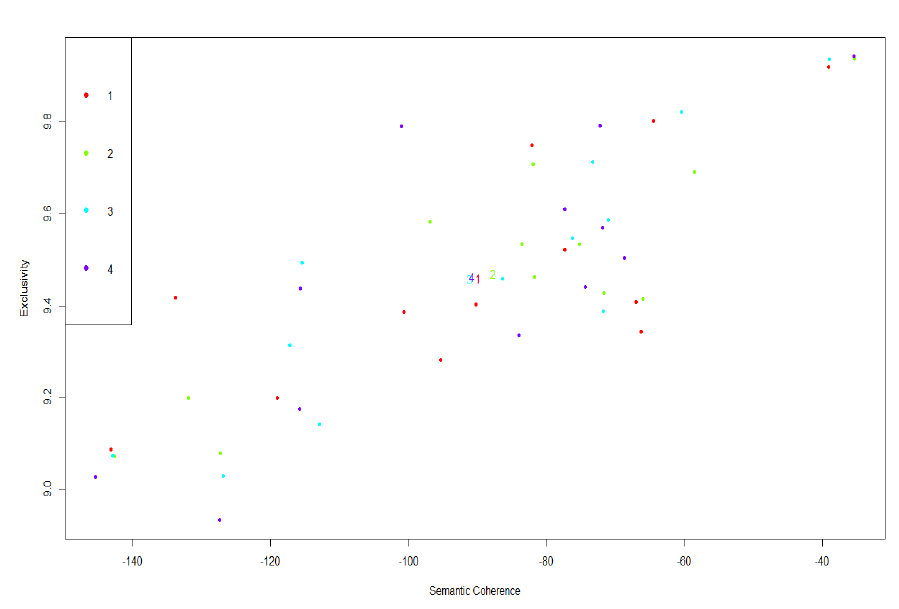
Figure A4. Topic models selection in STM packages.